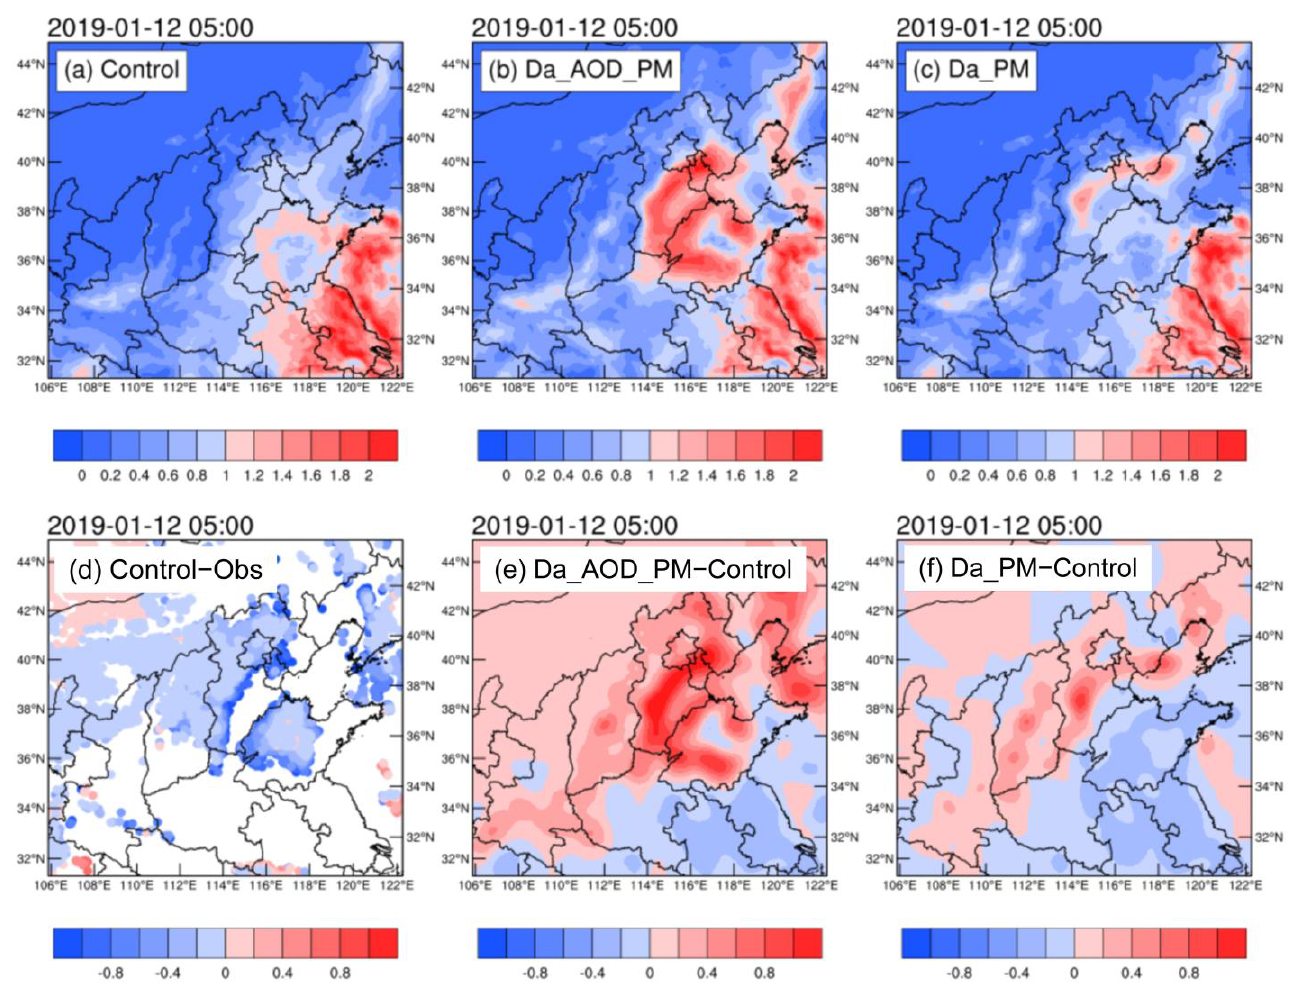
Figure 4. Distribution of AOD in the control IC ( a ), DA analysis ( b , c ), bias of the control IC ( d ), and DA increments ( e , f ).